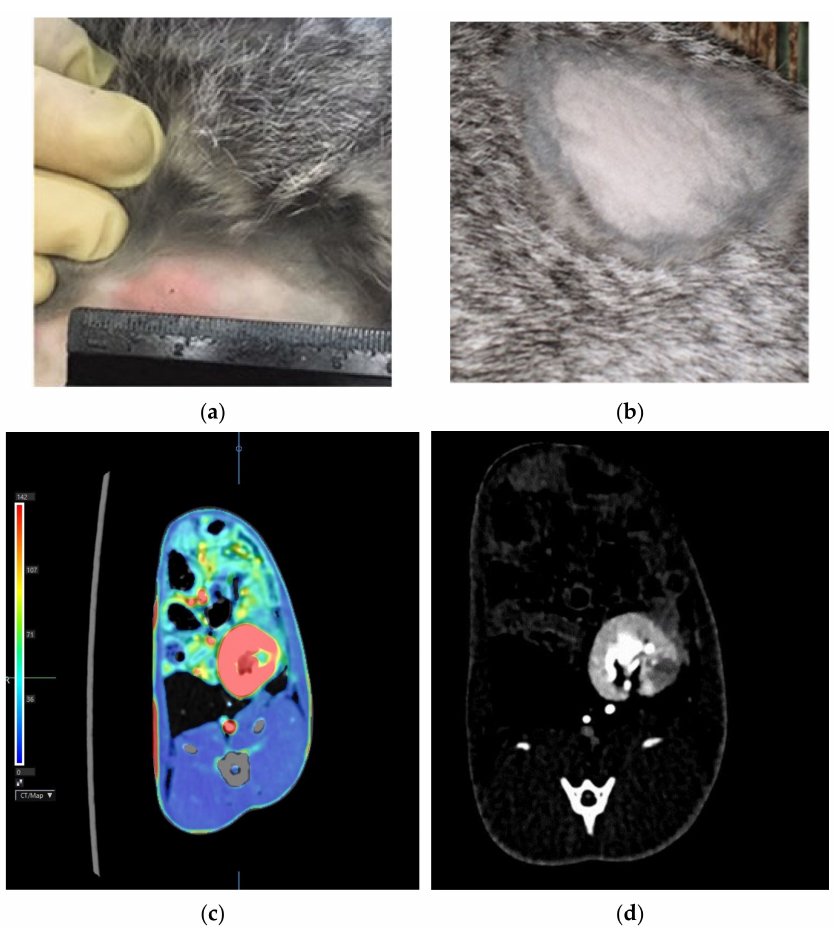
Figure 2. Hyperergic erythema type reaction in response to intradermal administration of Diaskintest 30 days after the challenge ( a )—infected rabbit; ( b )—intact rabbit). Abdominal CT: ( c )—a clearly defined area of reduced perfusion is determined in the left kidney (green color reflects the low blood flow compared to the remaining parenchyma (red)); ( d )—the destruction focus (the hypovascular area) in the area during standard computed tomography.